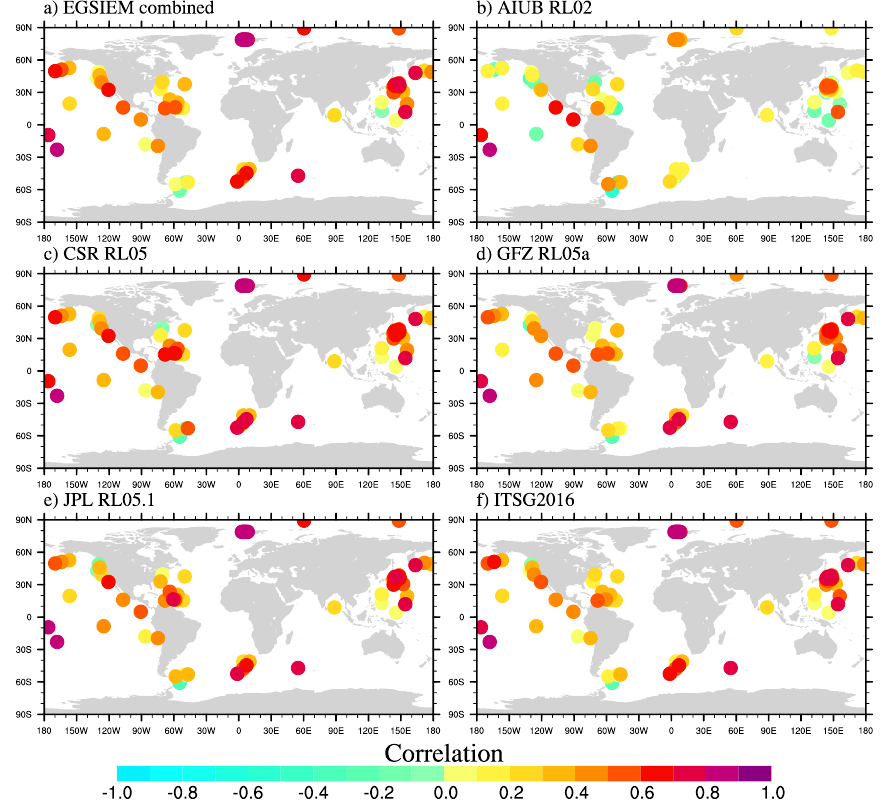
Figure 6. Correlations between in-situ ocean bottom pressure and GRACE-derived pressure over 103 ocean bottom pressure in-situ